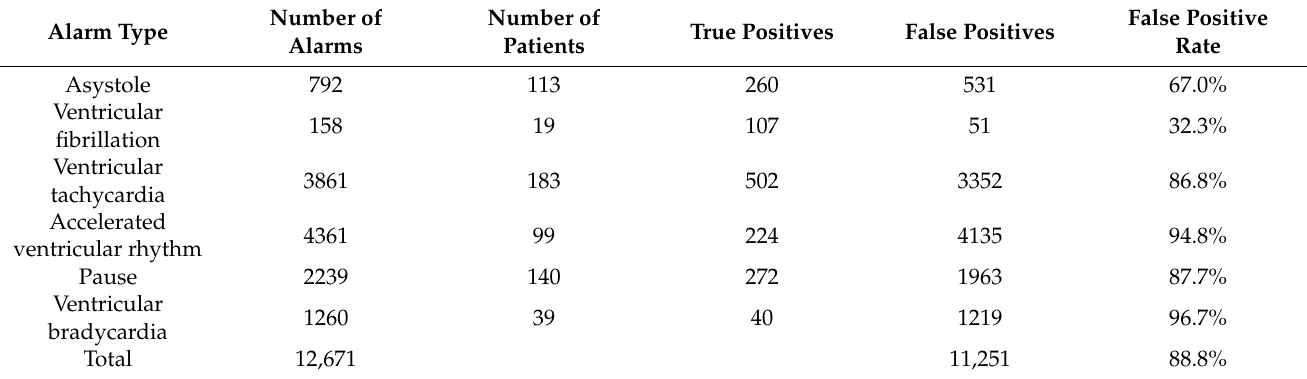
Table 1. Accuracy of 12,671 audible arrhythmia alarms.